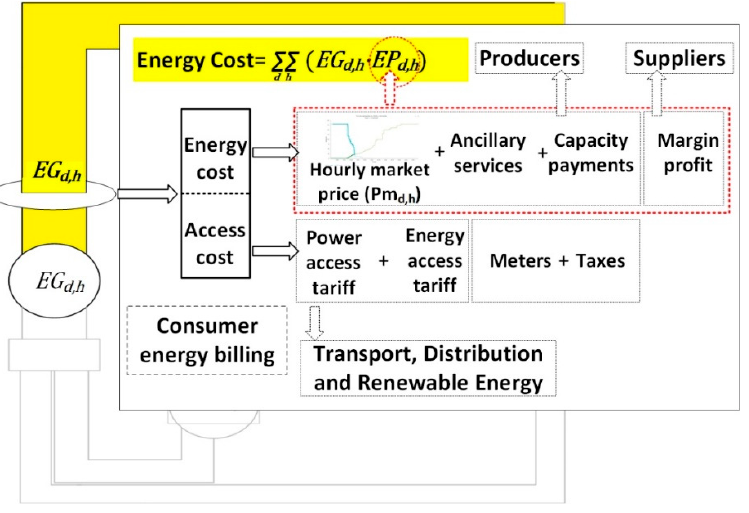
Figure 4. Representation of the consumer’s billing structure. Source: self-elaboration.